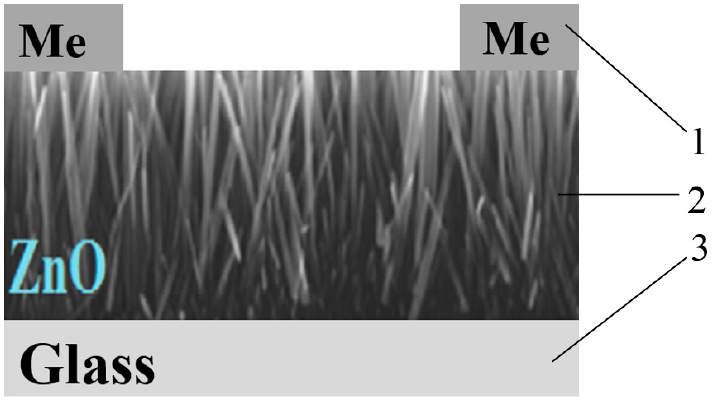
Figure 1. Schematically of the sensing element. С ontact metallization V-Cu-Ni (1), array of ZnO nanorods (2), glass substrate